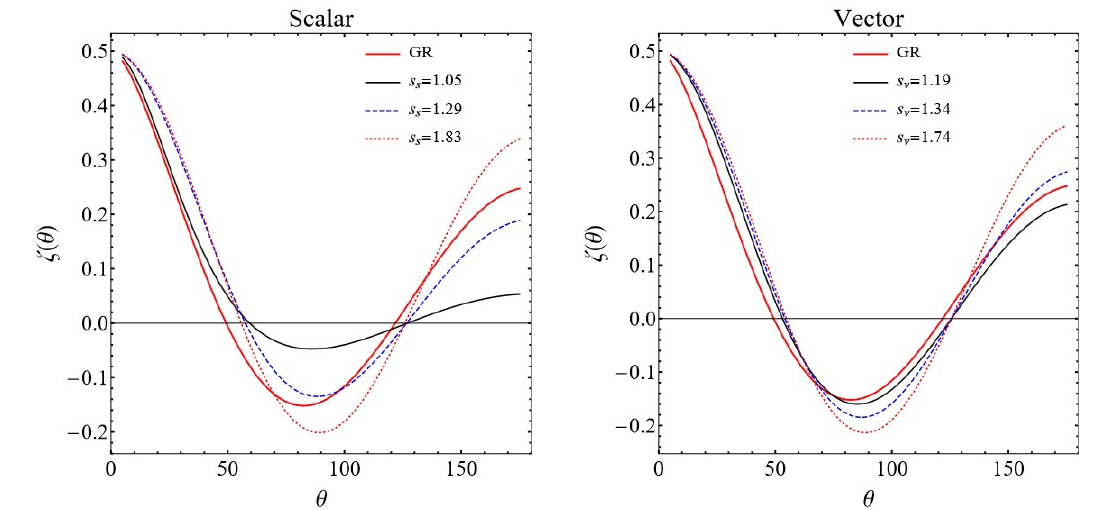
Figure 1. The normalized cross correlation function ζ ( θ ) for the scalar (the left panel) and the vector (the right panel) GWs when c i have the values shown in the left table in Table 1.